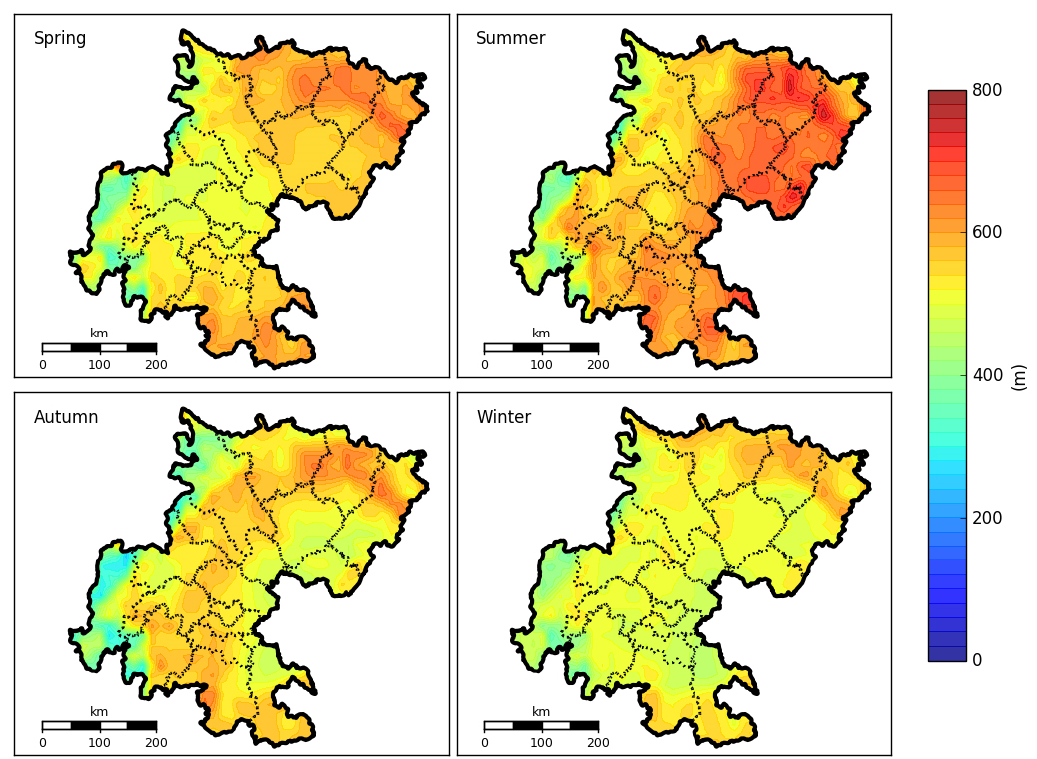
Figure 7. The simulated spatial distribution of planetary boundary layer height over the Sichuan Basin during 1 November 2013 to 31 October 2014. Atmosphere 2018 , 9 , x FOR PEER REVIEW